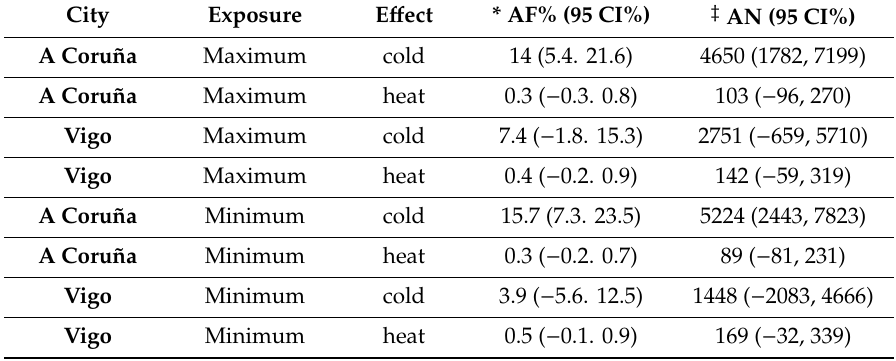
Table 2. Emergency medical calls attributable to heat and cold by exposure variable and city. City Exposure E ff ect * AF% (95 CI%) ‡ AN (95 CI%) A Coruña